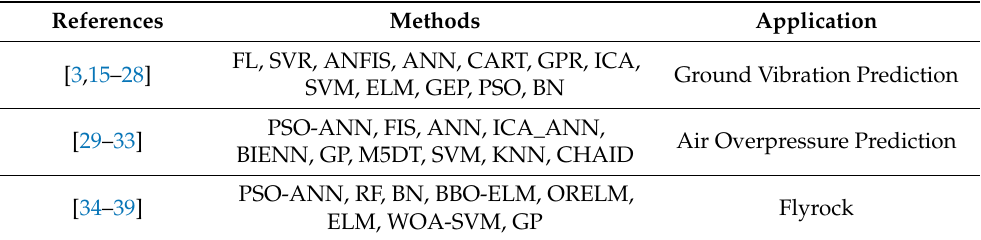
Table 1. AI Models developed and applied to predict ground vibration, air overpressure and flyrock.